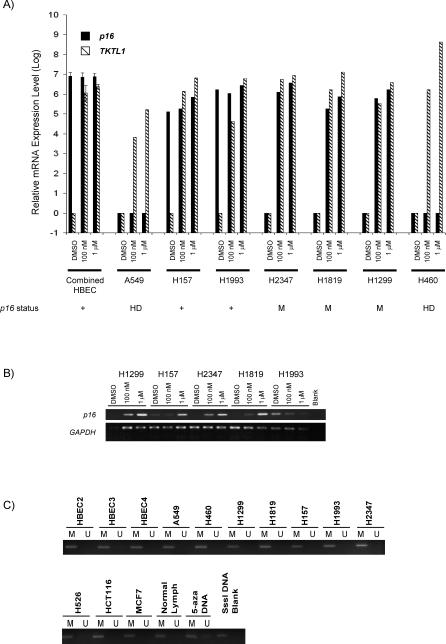
5-Aza Treatment Induces Genes Silenced by Promoter Methylation in HBEC and NSCLC Cell Lines(A) QPCR for p16 and TKTL1 in HBEC and NSCLC. Solid bars are p16 and cross-hatch bars are TKTL1. Data are normalized, relative mRNA expression levels according to the 2ΔΔCt method. HBEC2, 3, and 4 had similar profiles and were combined; data are averages and error bars are ± standard deviation. p16 status is indicated below each cell line; +, expressed; HD, homozygous deletion; M, methylated.(B) RT-PCR for p16 in the indicated cell lines. GAPDH is a loading control.(C) Methylation-specific PCR for TKTL1 in the indicated samples shows complete methylation in all samples examined, both methylated (M) and unmethylated (U). SssI in vitro-methylated DNA was used as a positive control for the methylated primers, and 5-aza-treated DNA was a positive control for the unmethylated primer sets (for PCR conditions and primer sequences see Protocol S1).